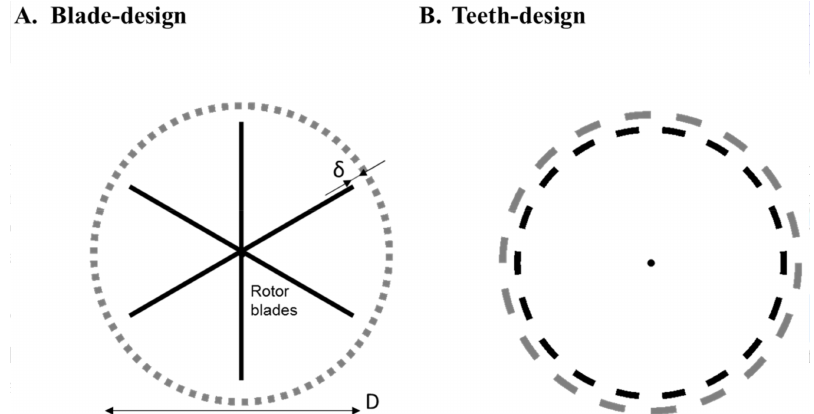
Figure 3. Schematic representation of a rotor-stator head with blade-design ( A ) and teeth-design ( B ). D denotes the rotor diameter, and δ denotes the rotor-stator clearance.